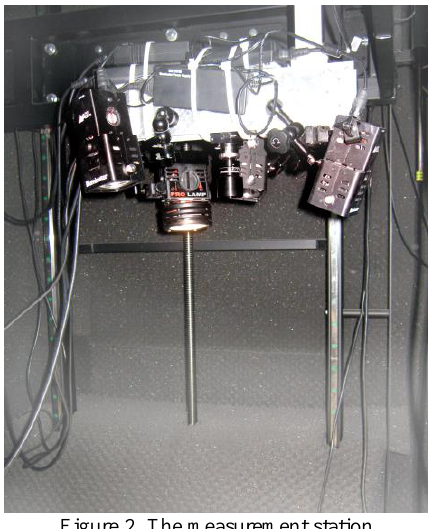
Figure 2. The measurement station